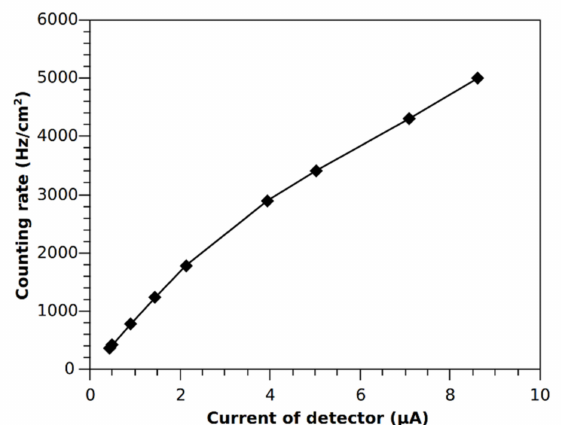
Figure 8. The relation of the counting rate with respect to the operating current of the detector. The error bars are contained within the size of the symbol.